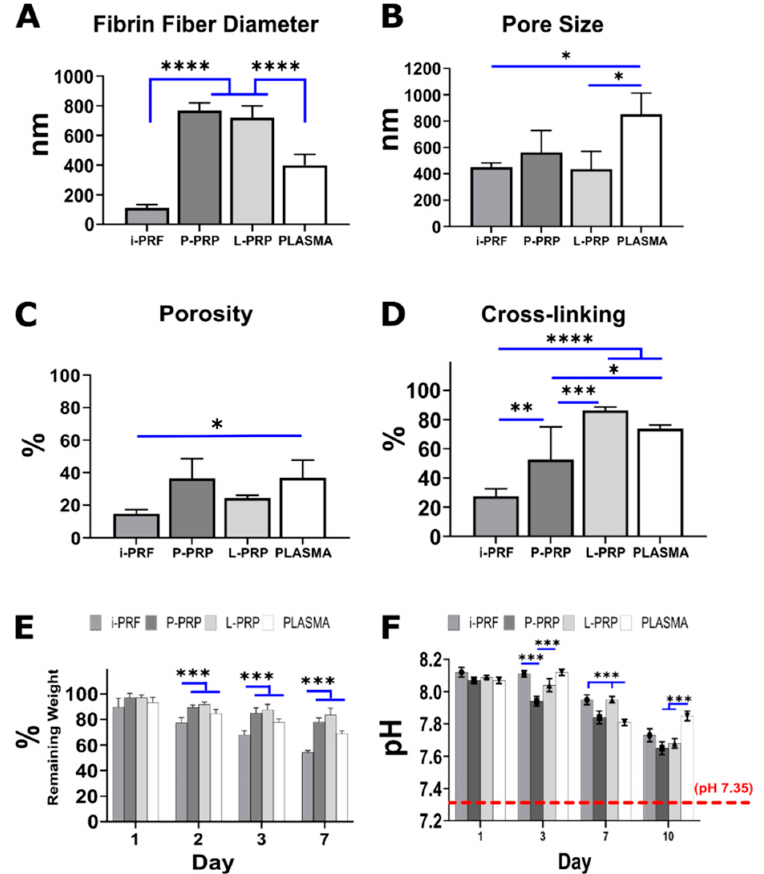
Figure 2. Characterization of the fibrin network within the different hemoderivatives. Fibrin fiber diameter ( A ), pore size ( B ) and porosity ( C ) were determined via SEM images. Cross-linking ( D ), weight loss ( E ) and pH ( F ) using media calibrated a pH 7.35 physiological value (red do tt ed line) as reference. Results are expressed in mean and standard deviation. Statistically di ff erence was determined at (**** p < 0.0001), (*** p < 0.001), (** p < 0.01) and (* p < 0.05).